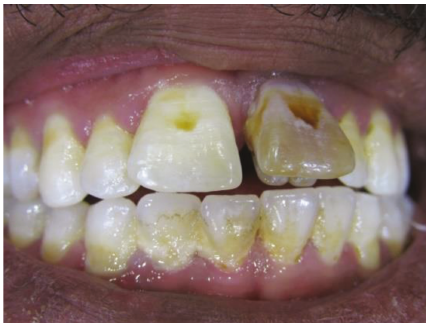
Figure 2: Case1: discolored necrotic left central incisor (facial